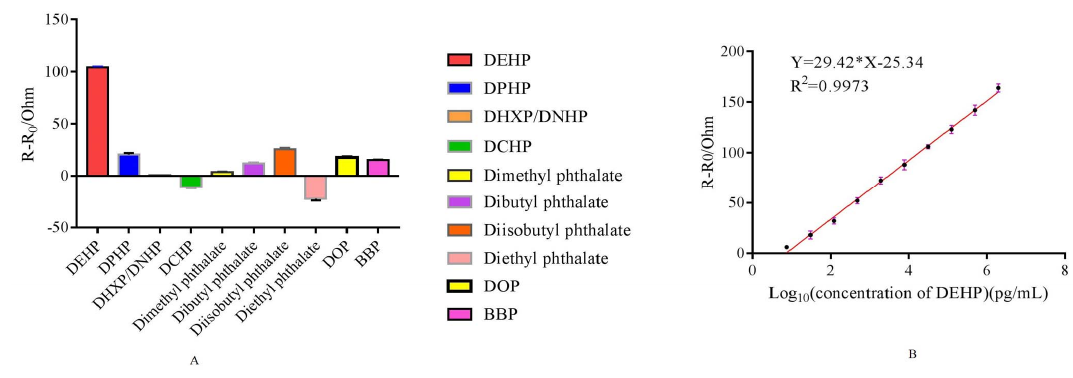
Figure 6. Specificity and sensitivity of EIS aptasensor. ( A ) Identification of the specificity of aptamer 31 against DEHP. The concentration of DEHP and analogs was 30.518 pg/mL. ( B ) Analytical curve of DEHP detection based on ultrasensitive EIS aptasensor. Table 2. Comparison of available methods for analysis of DEHP.